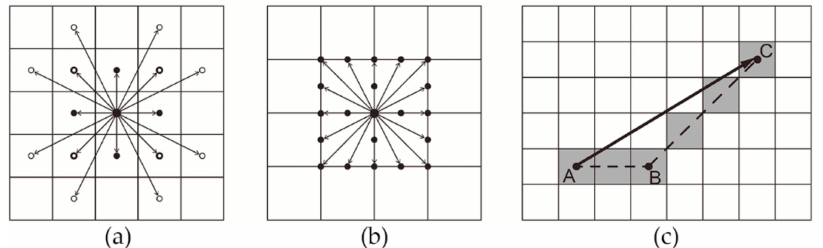
Figure 2. Di ff erent methods for improving the accuracy of shortest distance: ( a ) connecting a cell with indirect neighbor cells when the network nodes are located at the center of raster cells [31]; ( b ) adding the number of adjacent nodes when the network nodes are located at the boundary of raster cells [32]; ( c ) smoothing the path in post-processing